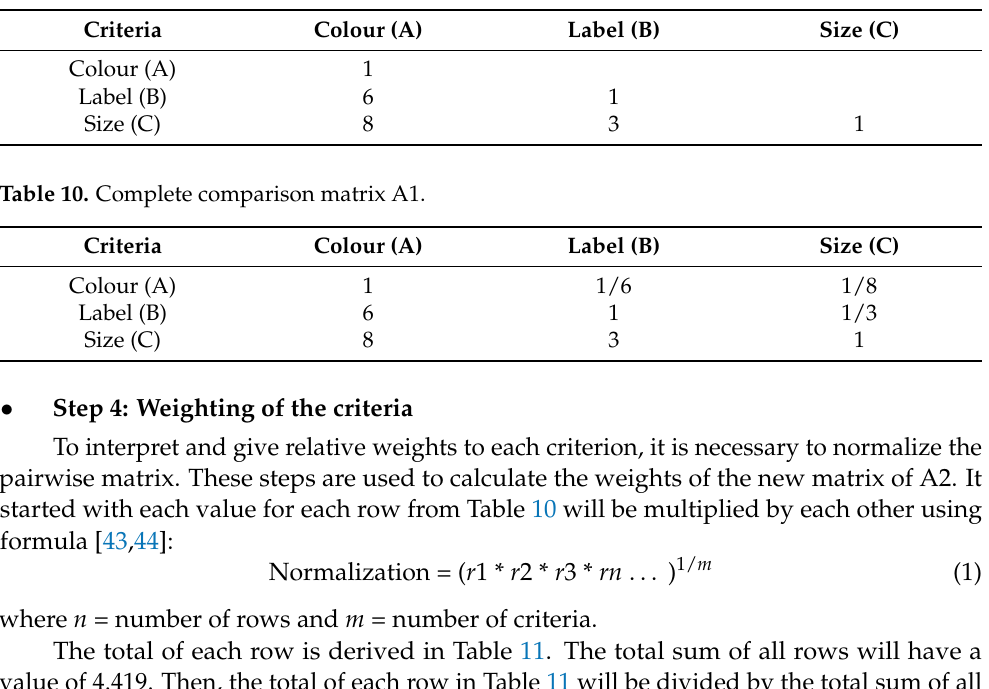
Table 9. Corresponding histogram matrix visualization.